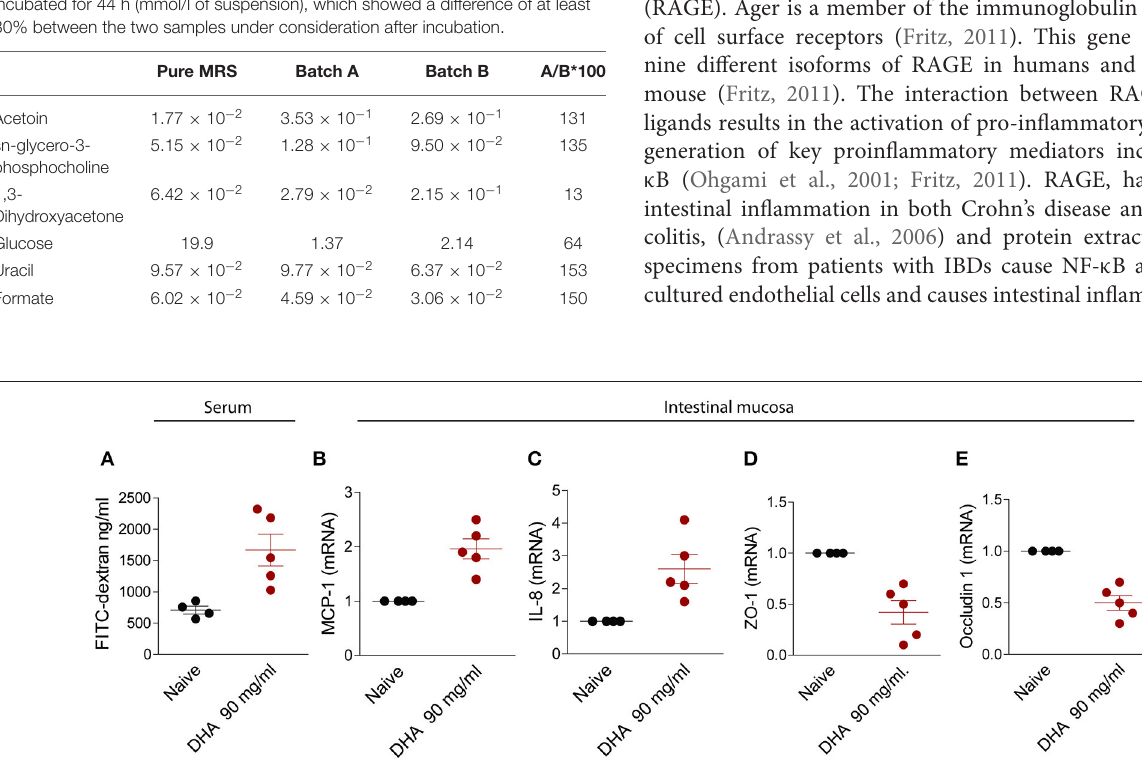
Frontiers in Pharmacology |